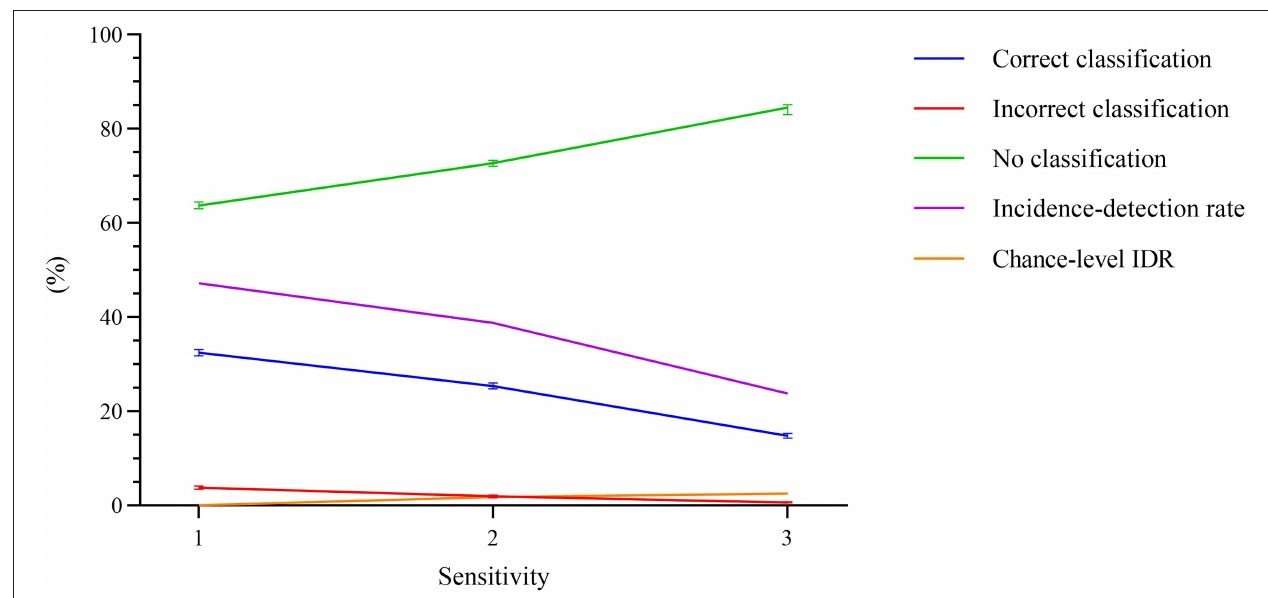
FIGURE 8 | Percentage of error trials that were correctly detected, incorrectly detected, or no detection was observed, as a function of the sensitivity. The error bars represent the 99% confidence interval for the averages. The incidence-detection rate (IDR) metric, represented using pink line, is highest at sensitivity level 1. The chance-level IDR, calculated using a permutation test, is also shown in